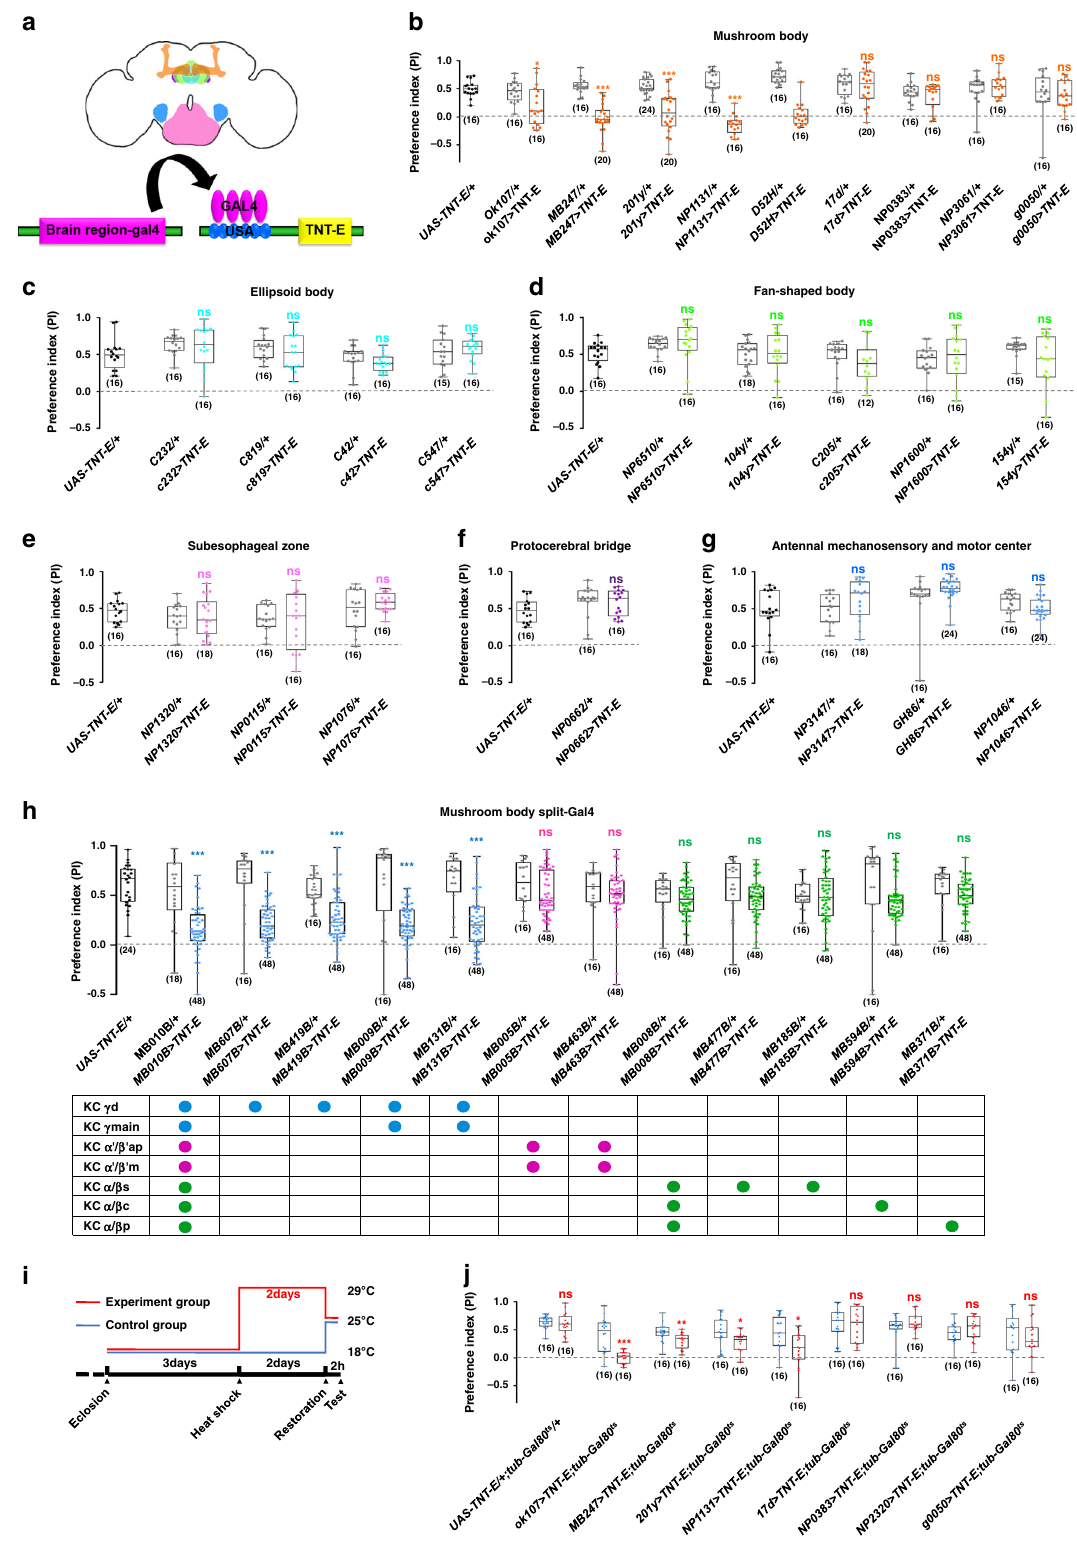
higher tendency to af fi liate with D. repleta than did the controls (Fig. 4d). The results demonstrated that the activity of KC γ neurons regulated the fl ies ’ motivation for social af fi liation, suggesting that KC γ neurons function as a critical integration centre for